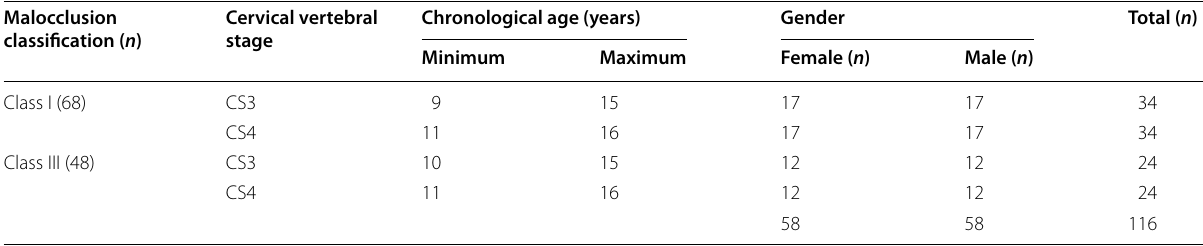
Table 1 Descriptive information of sample population Malocclusion classification ( n )